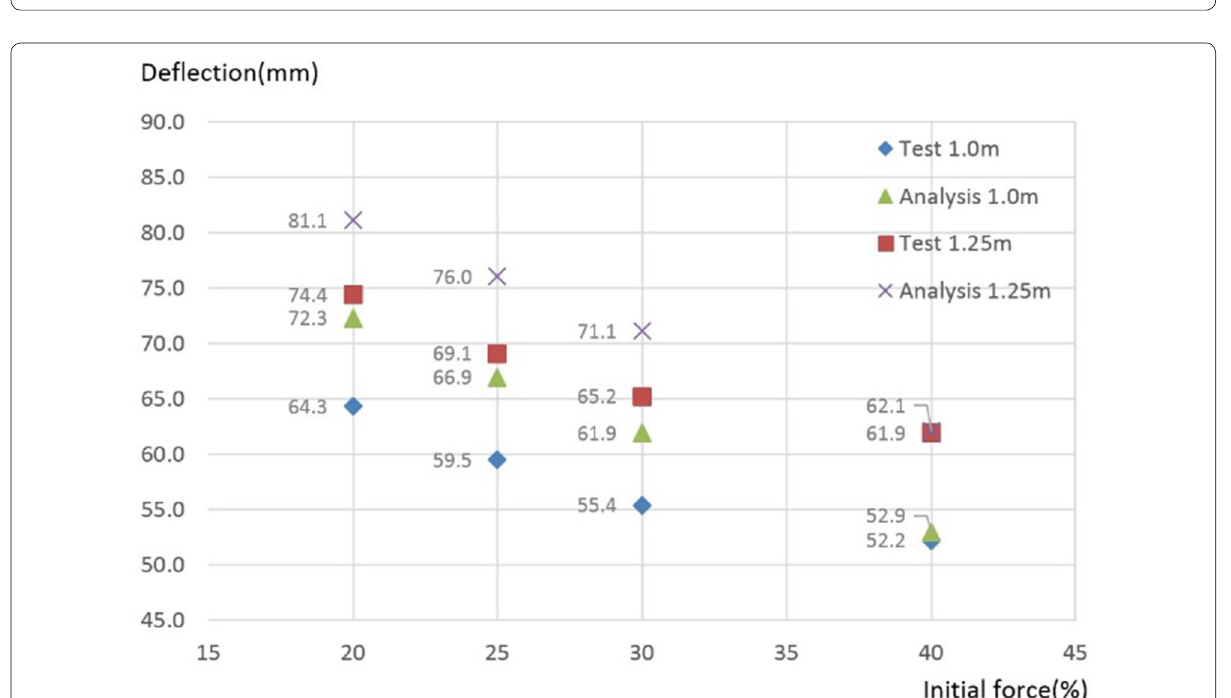
Fig. 10 Comparison of test and analysis for tensile force.